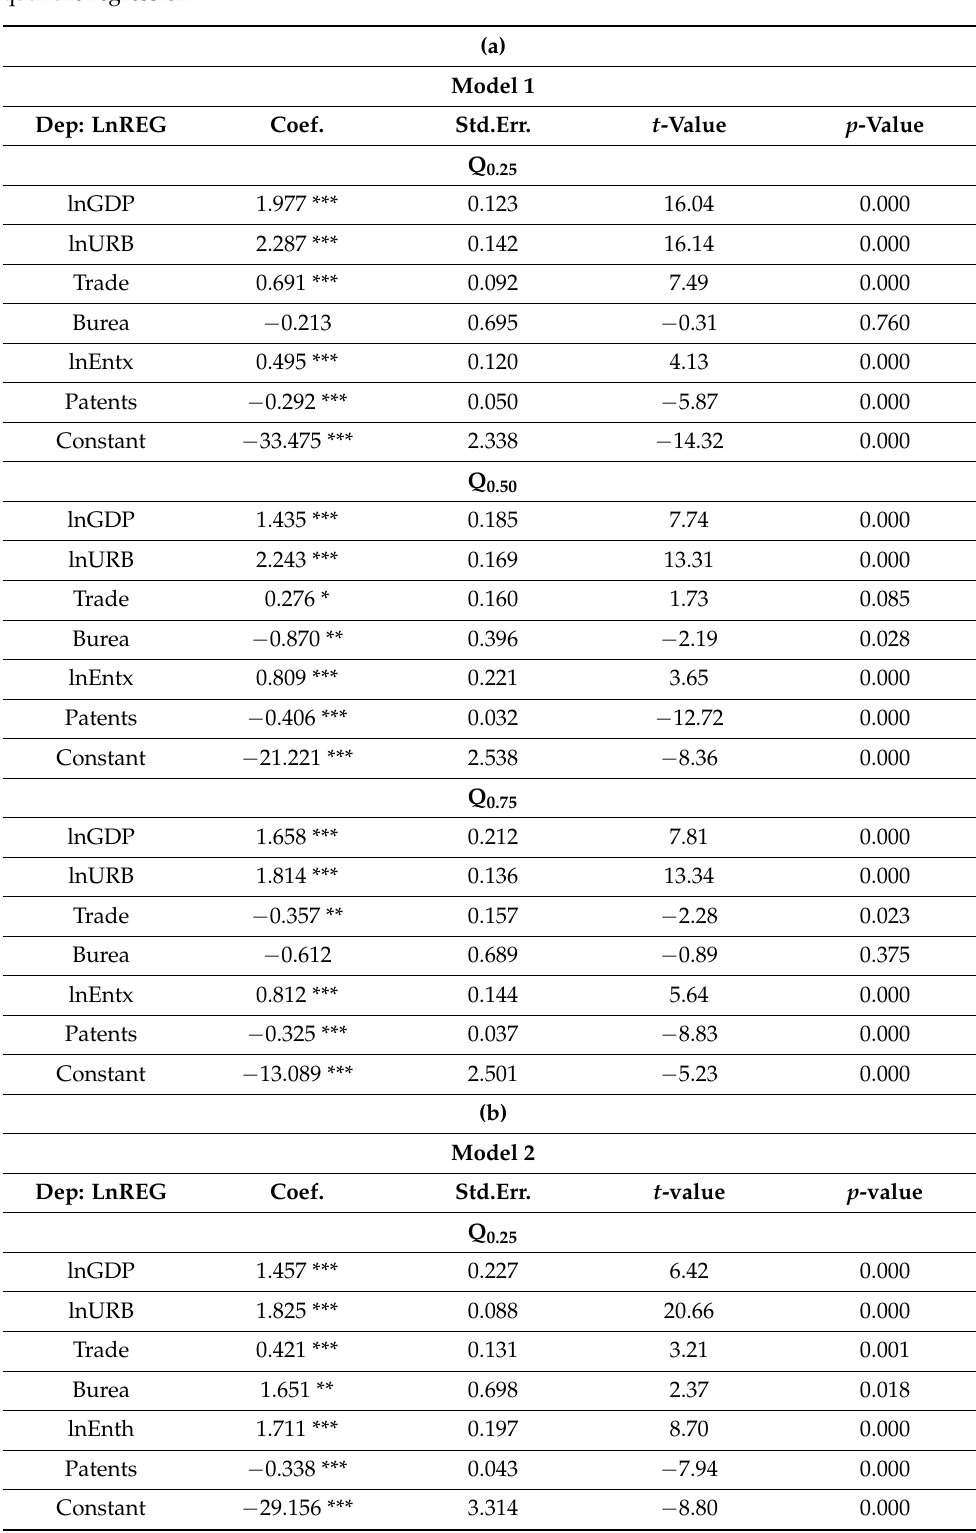
Table 7. (a) Estimates of quantile regression. (b) Estimates of quantile regression. (c) Estimates of quantile